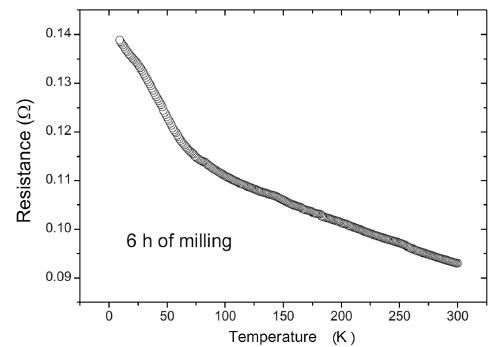
Figure 5. Resistance as a function of temperature of as-milled (6 h) and compacted